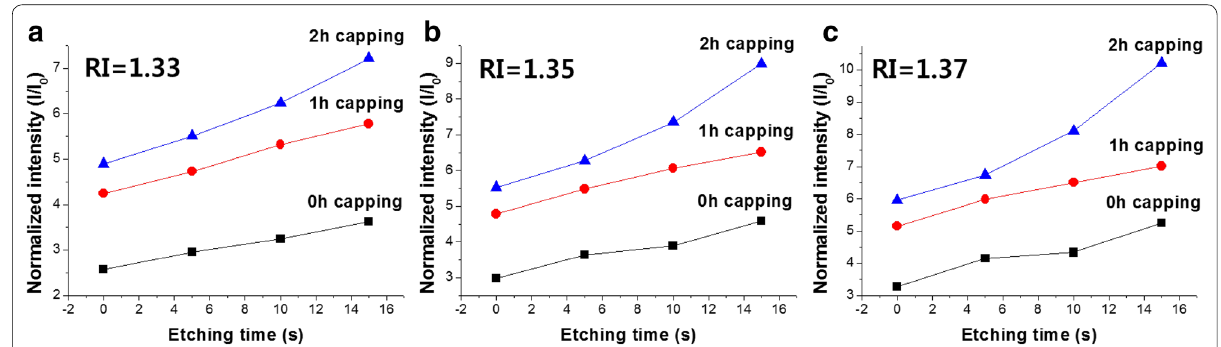
Fig. 4 LSPR signal change with Au capping time and etching time a RI